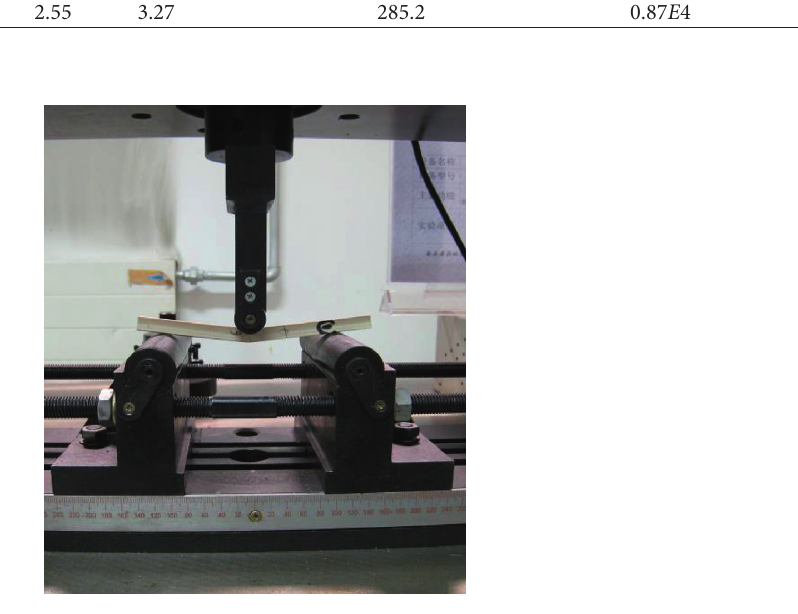
Figure 8: Bending strength test. Table 6: Bending strength of